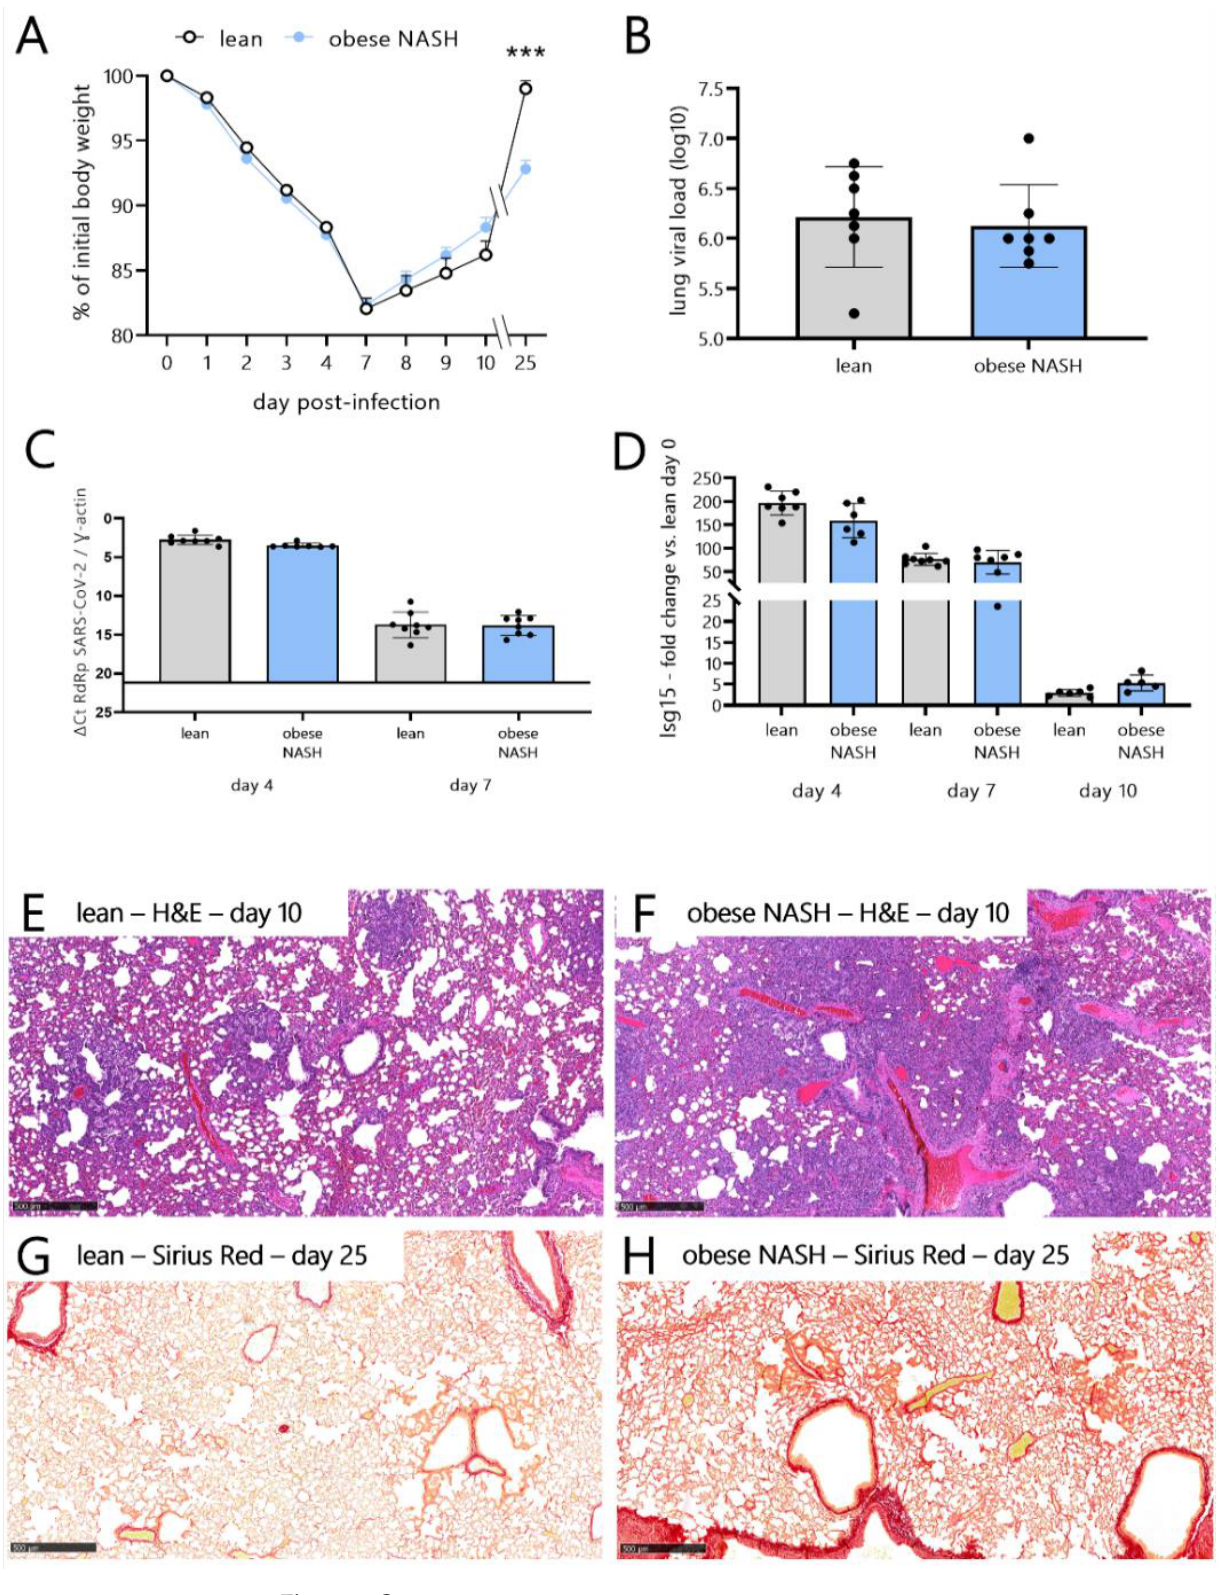
Figure 2. Impact of SARS-CoV-2 infection on lean hamsters vs. obese NASH hamsters. Hamsters were inoculated intranasally with 2 × 104 TCID50 of the clinical SARS-CoV-2 isolate hCoV- 19/France/lDF0372/2020. ( A ) Changes in body weight (as the mean ± SD percentage of the initial